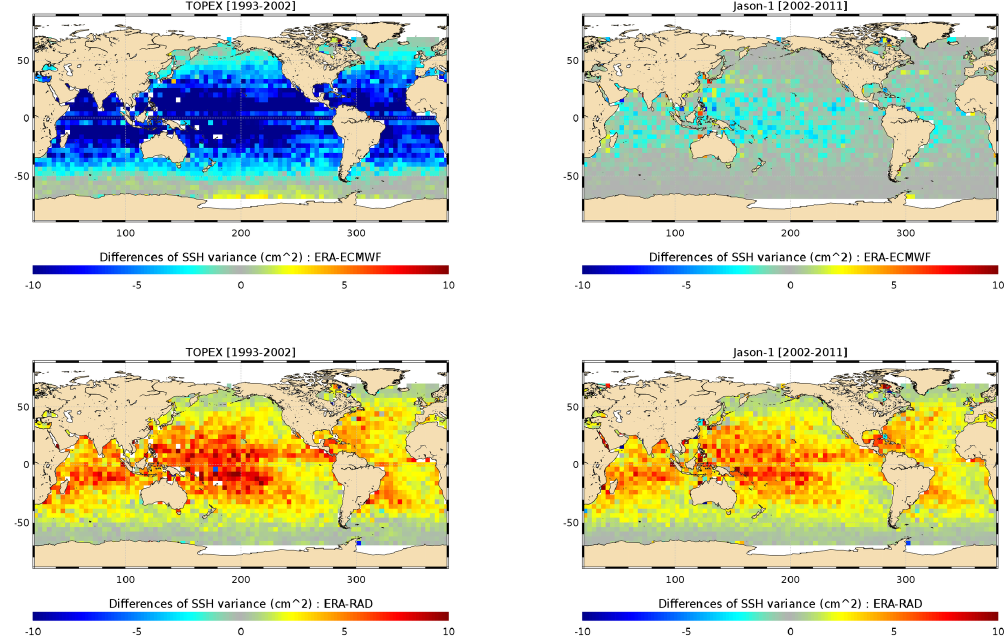
Figure 2. Map of SSH variance differences at crossovers (in cm 2 ) using the ERA-Interim and radiometer wet troposphere corrections (bottom) and the ERA-Interim and ECMWF wet troposphere correction (top) successively in the calculation of SSH. Statistics have been computed over the first altimetry decade (from 1993 to 2002) using TOPEX data (left) and the second altimetry decade (from 2002 to 2011) using Jason-1 data.